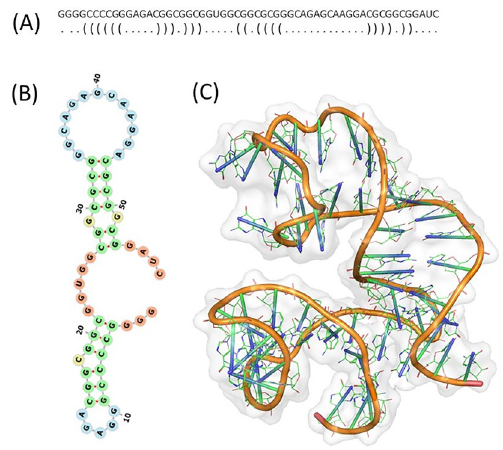
Figure 1. APP IRE mRNA sequence and dot-bracket notation ( A ) for secondary structure ( B ), and tertiary ( C ) structure prediction.